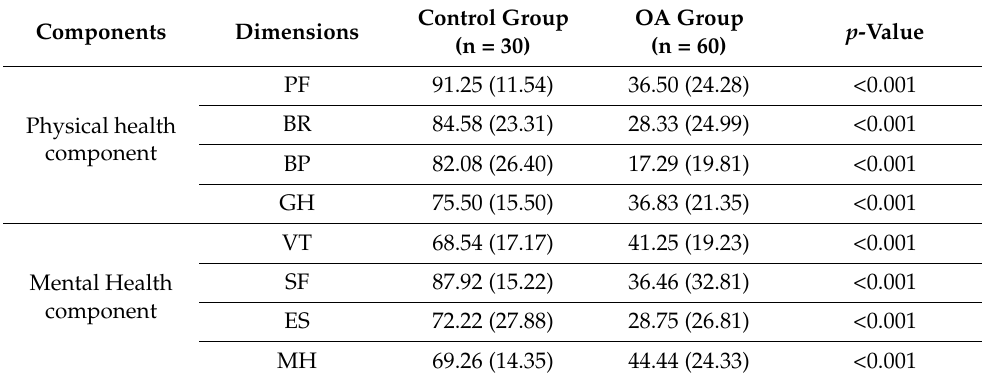
Table 2. Mean and standard deviation of the SF-36 in the control and osteoarthritis groups.